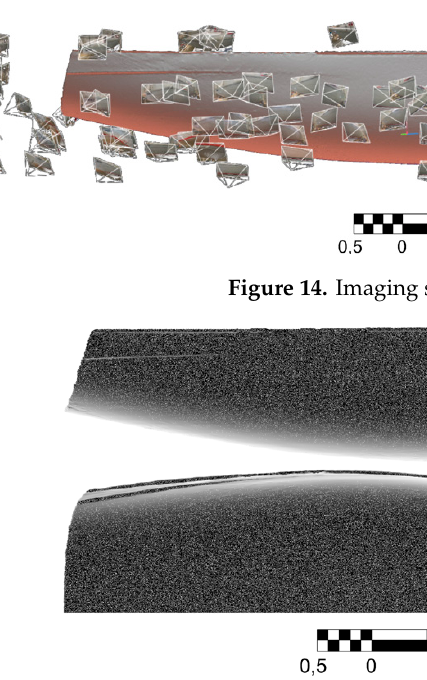
Figure 15. Final point cloud from the 2nd measurement by the SfM method.